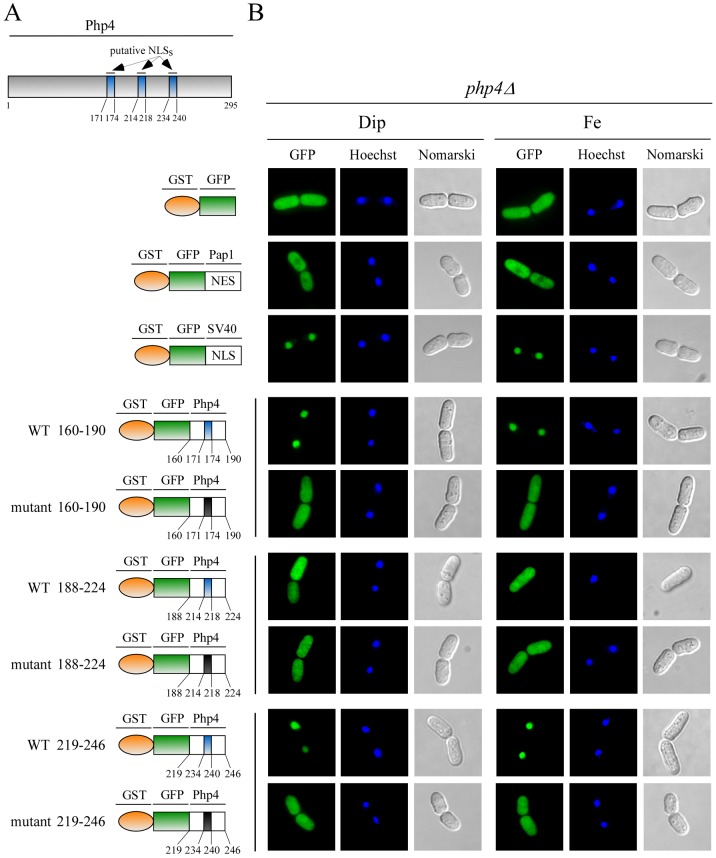
Amino acid fragments 160–190 and 219–246 of Php4 contain nuclear import activity.
A, Schematic representation of Php4 and several GST-GFP fusion reporter proteins containing NES or NLS regions of different proteins such as Pap1, SV40, and Php4. Color codes are, orange (GST), green (GFP), blue (putative Php4 NLS) and black (mutated NLS). B, Shown are representative php4Δ cells expressing GST-GFP, GST-GFP-Pap1NES, GST-GFP-SV40NLS, GST-GFP-Php4160NLS190, GST-GFP-Php4160mutantNLS190, GST-GFP-Php4188NLS224, GST-GFP-Php4188mutantNLS224, GST-GFP-Php4219NLS246, and GST-GFP-Php4219mutantNLS246, respectively. Cultures were grown in thiamine-free media for 12 h. After 3 h treatment in the presence of Dip (250 μM) or FeCl3 (Fe) (100 μM), cells were analyzed by fluorescence microscopy for GFP. As controls, nuclear DNA was visualized by Hoechst staining and cell morphology by Nomarski optics. The results shown are representative of five independent experiments.